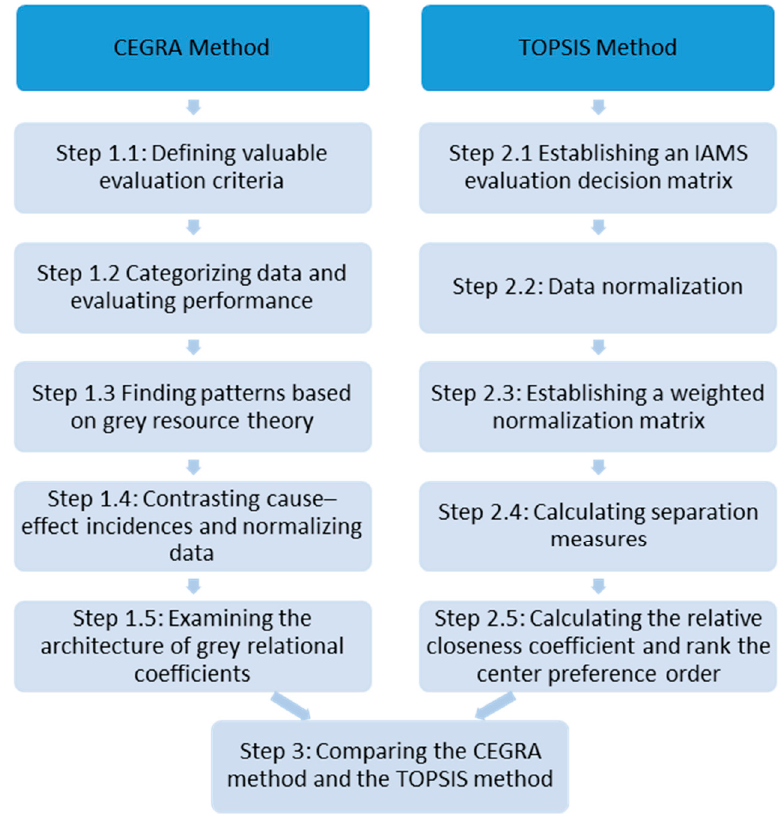
Figure 1. Comparing the CEGRA method and the TOPSIS method.